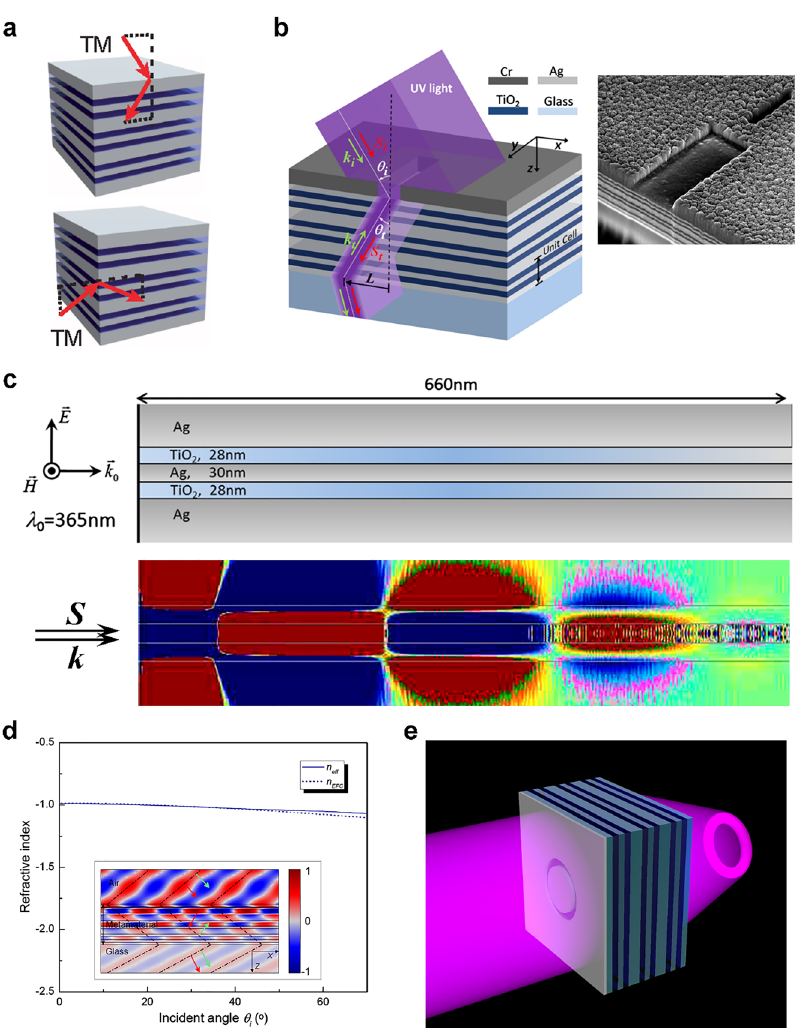
Figure 4: (a) Schematic drawing of all-angle negative refraction for a stack of three MDMDM unit-cells for excitation along the plane of the layers (upper panel), and orthogonal to them (lower panel). TM polarized light is utilized in both cases. Verhagen et al. [52]. © 2010 American Physical Society. (b) Left: schematic drawing of negative refraction from air into a metamaterial formed by three vertically stacked unit cells, each consisting of planar layers of Ag – TiO 2 – Ag – TiO 2 – Ag. The structure is coated with a beam-de fi ning mask consisting of a rectangular aperture (width: 600 nm, length:10 µm) inan opaqueCr fi lm (thickness: 120 nm).Right: scanning electronmicroscopyimage of cross-section of a fabricated device. (c) FDTD-calculated magnetic fi eld distribution of the plasmon mode in an MDMDM waveguide when excited at normal incidence from free-space at λ 0 = 364 nm. (d) Experimental values of refractive index (solid curve), and numerical values of refractive index (dotted curve), as a function of angel of incidence θ i , for TM-polarized light. Inset: FDTD-simulated magnetic fi eld distribution for θ i = 40 ° .